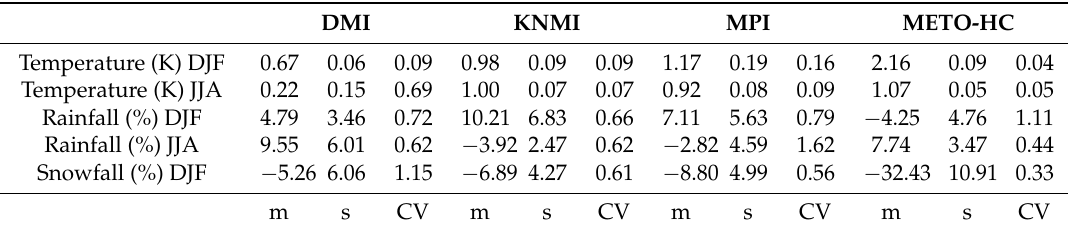
Figure 2. Percentage difference of mean rainfall in the winter season (DJF) between the periods 1961–1990 and 2011–2040. Table 4. Arithmetic mean values (m), standard deviations (s), and coefficients of variation (CV) of changes in temperature and precipitation in Austria according to the different RCM results (DJF: winter season; JJA: summer